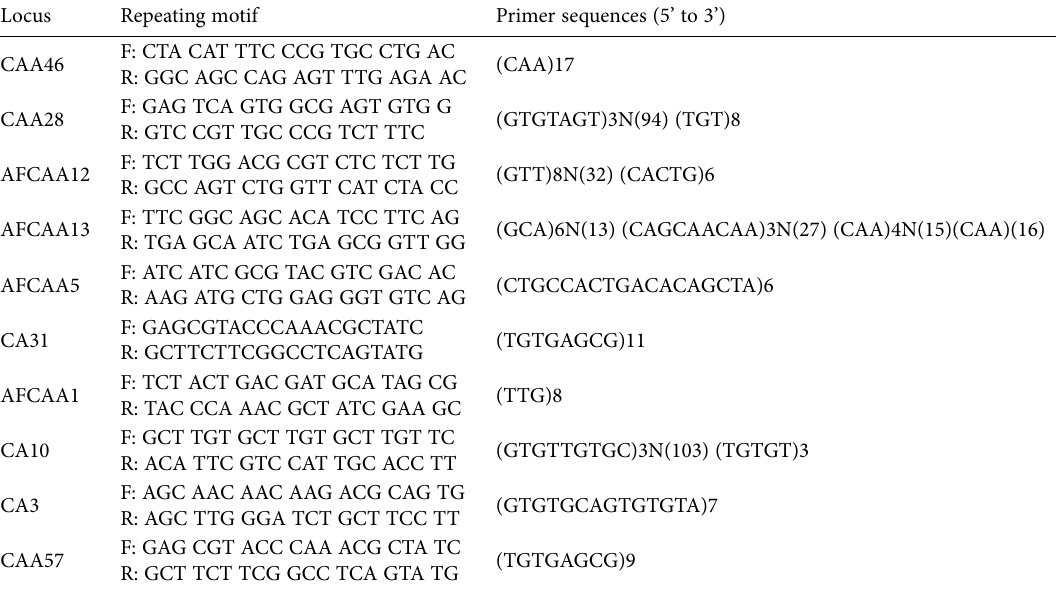
Table 2. Primer sequences of the ten SSRs markers used for genetic study of Ascochyta fabae isolates. Locus Repeating motif Primer sequences (5’ to